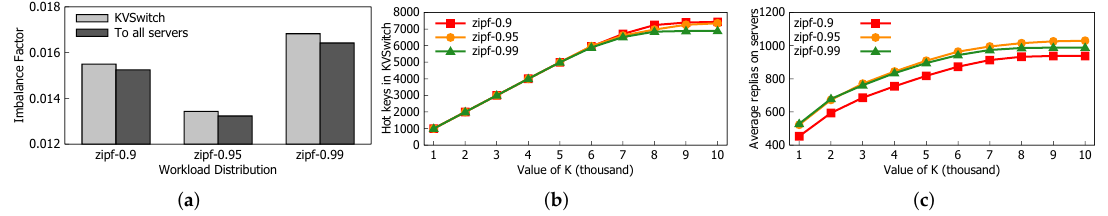
Figure 9. Dynamic change of the threshold. ( a ) The change of the threshold; ( b ) Number of hot keys. ( c ) Number of